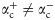
Learning curves and model estimates.(A) Task conditions. (B) and (C) Learning curves as a function of the task conditions in Experiment 1 and Experiment 2, respectively. Each panel displays the result of the corresponding condition presented in (A). The black dots and the error bars represent the actual data ± s.e.m. The green lines represent the model estimates of the biased models (Experiment 1: αc+≠αc−; Experiment 2:αCON≠αDIS), the grey lines represent the model estimates of the unbiased models (Experiment 1: αc+=αc−; Experiment 2: αCON = αDIS).